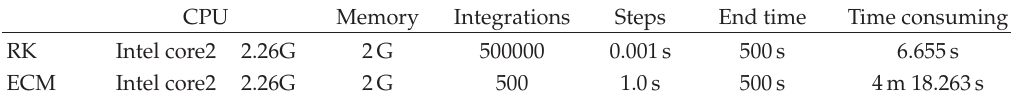
Table 3: Comparison of computing e ffi